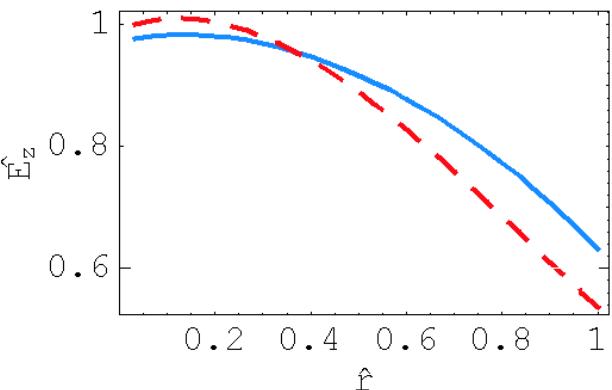
FIG. 2. (Color) Example of Figs. 14 and 15 of Ref. [6]. The (cid:3) 1 with q (cid:3) 1 . The solid curve initial density modulation is ^ a 1 d (blue) is at ^ z (cid:3) 0 , and the dashed curve (red) is at ^ z (cid:3) 10 . Notations have the same meaning as in Ref. [6] and are defined is normalized. in the text. The ^ E z